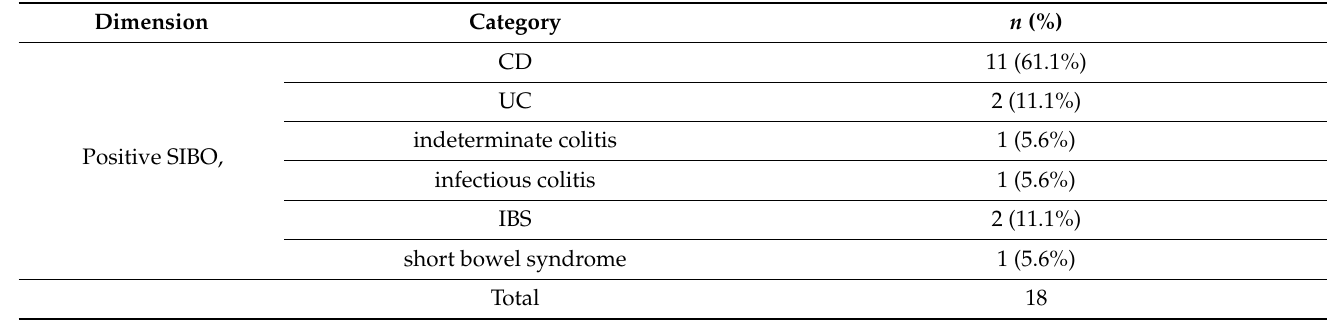
Table 2. Patients with positive testing for SIBO are provided in detail in this table.